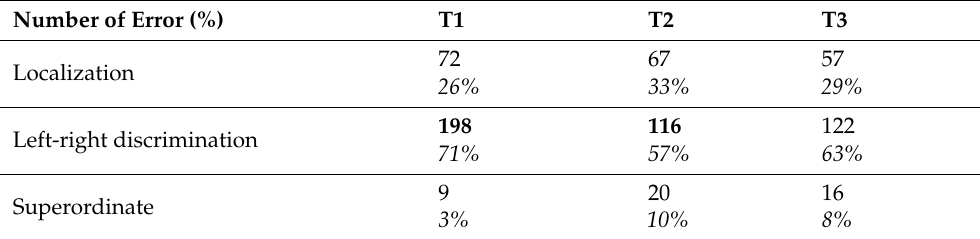
Table 2. Changes of number of error and percentage (%) with time period (T1, T2, and T3) for each type of error (localization, left–right discrimination, and superordinate). Bold indicate significant change between T1 and T2 on the number of